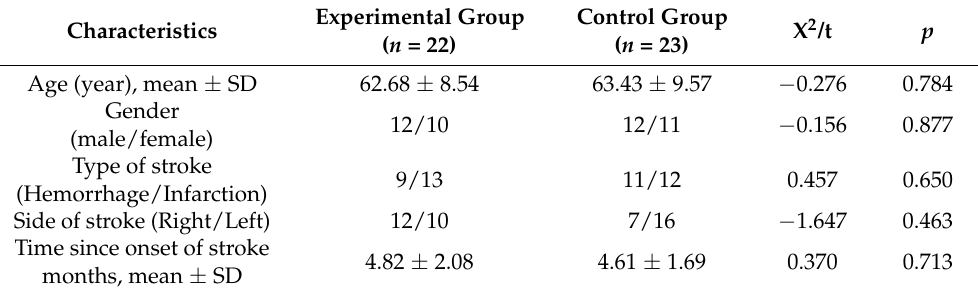
Table 1. Characteristics of